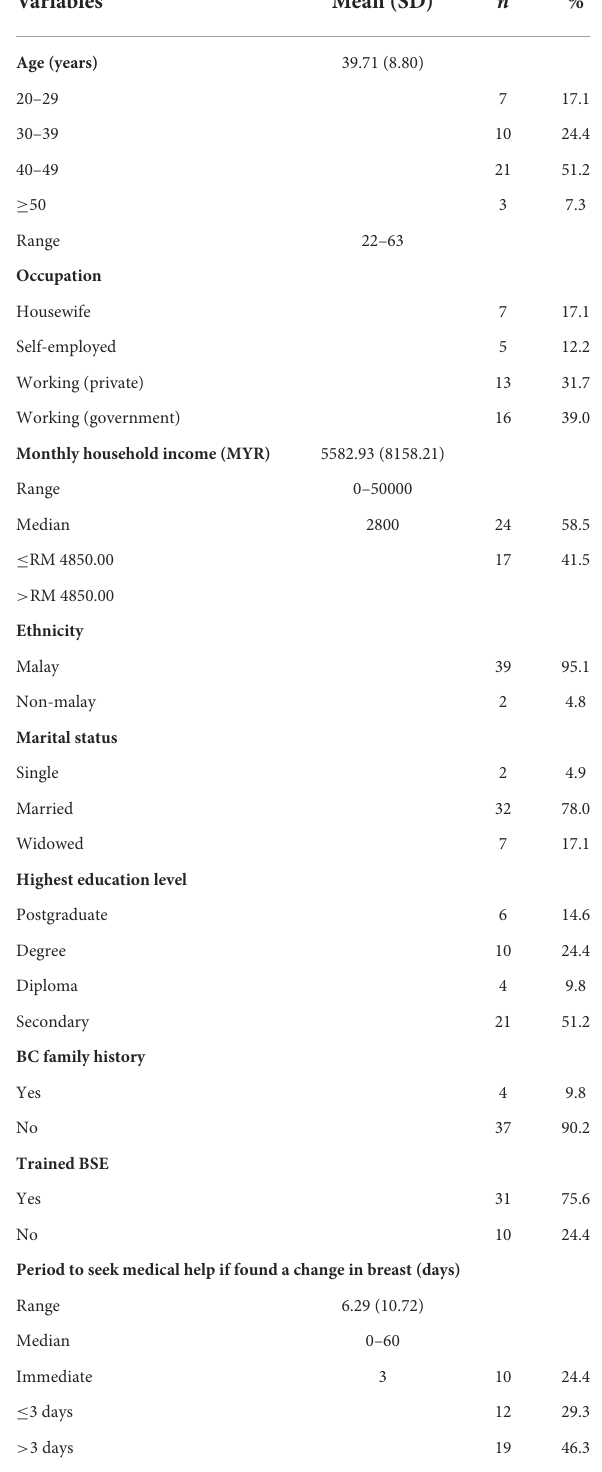
TABLE 1 Socio-demographic characteristics of participants ( n =